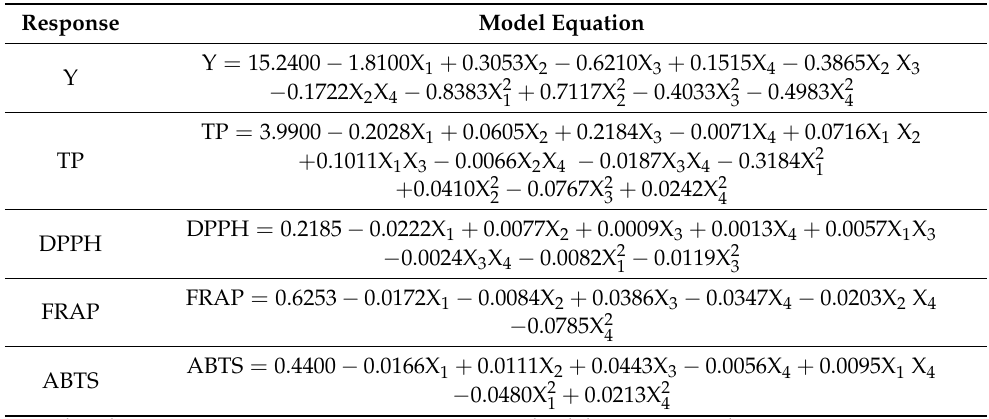
Table 4. Predictive model equations in coded values for total extraction and phenols yield and antioxidant activity obtained by